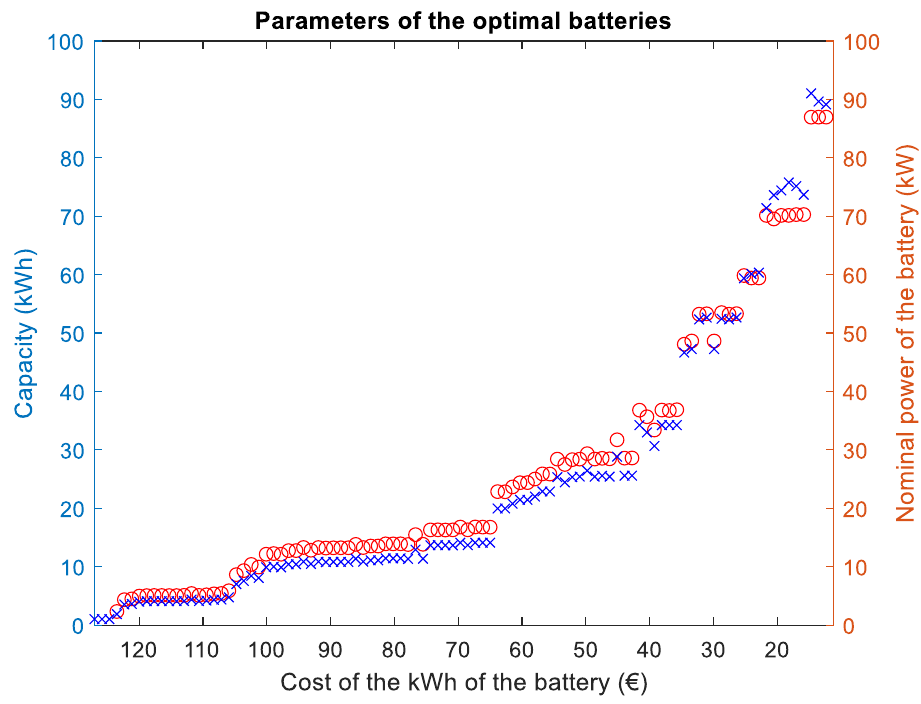
Figure 8. Optimal battery capacities (kWh) and nominal power (kW) along the iterations of the sensitivity algorithm.